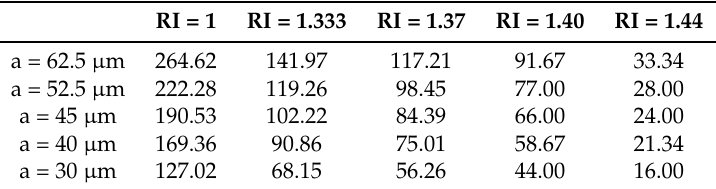
Table 1. The normalized frequency V at different radii and cladding